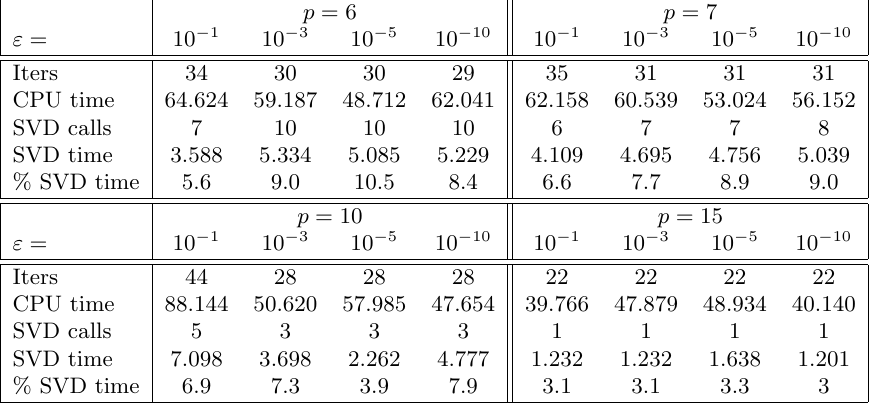
Table 5. Performance of the DBRR method for Problem 3.